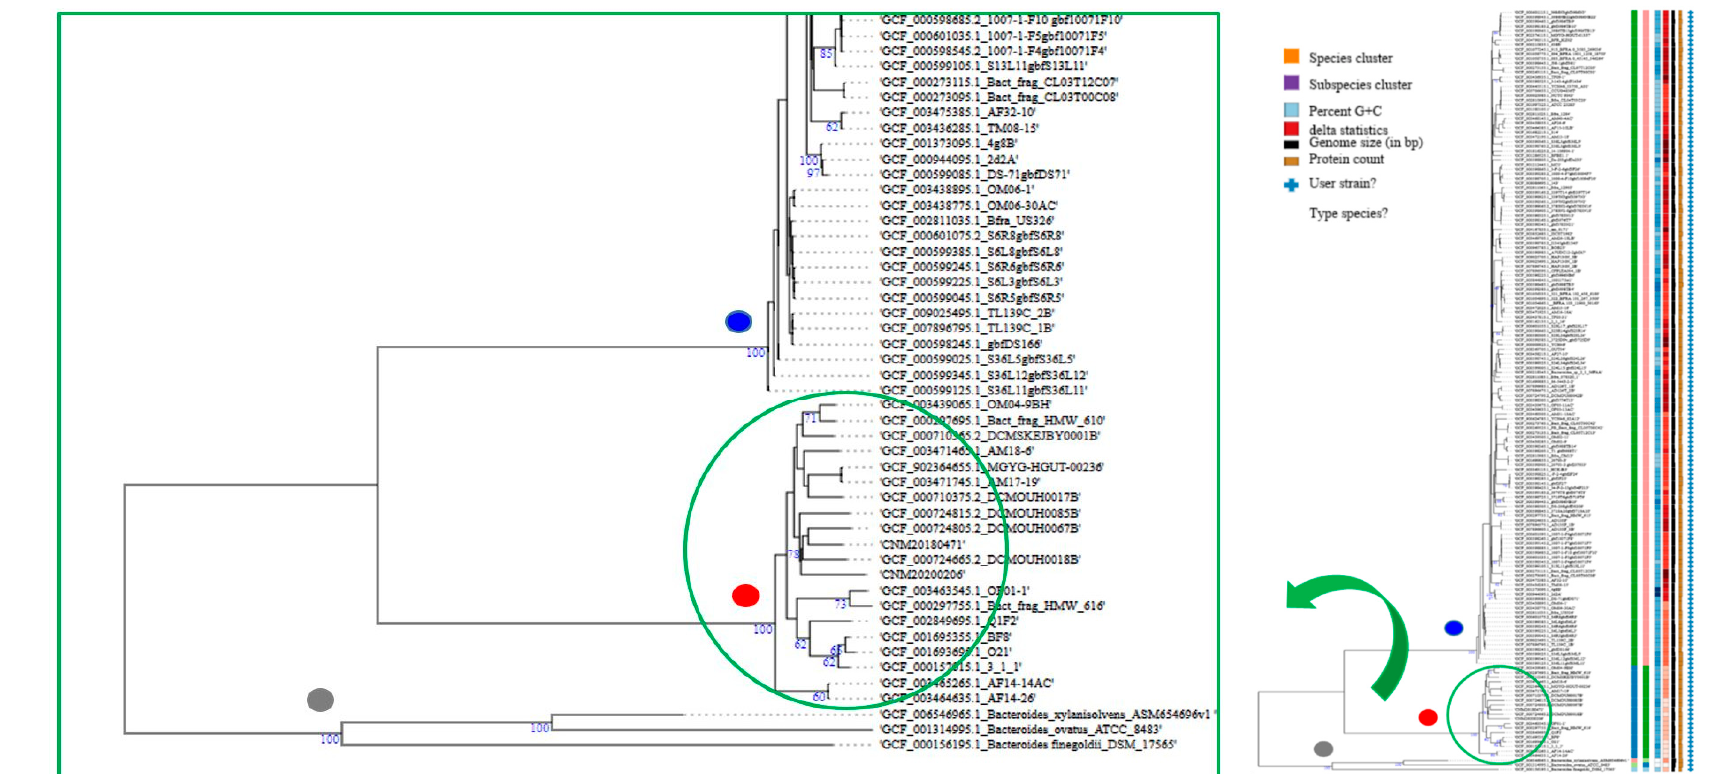
Figure 1. B. fragilis w hole-genome, sequence-based phylogenetic tree constructed using FastME v.2.1.6.1 software (which calculates genome BLAST distance phylogeny (GBDP) distances); the branch lengths are scaled in terms of the GBDP distance formula. The numbers above the branches are GBDP pseudo-bootstrap support values (all >60%; 100 replicates); average branch support = 27.9%. The trees were rooted at the midpoint. The results were provided by the Type Strain Genome Server (TYGS) (https://tygs.dsmz.de, accessed on 19 October 2020) [33]. The same color code was used in the chewBBACA analysis.